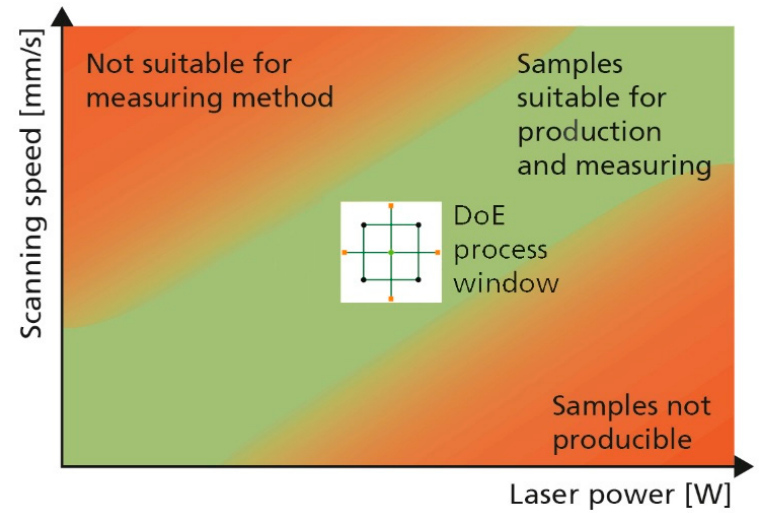
Figure 2. When choosing the test points (which define the process window) for a statistical experimental design for L-PBF (laser powder bed fusion) it is crucial to avoid areas causing faulty manufacturing or resulting in specimens unsuitable for the intended form of measurement.